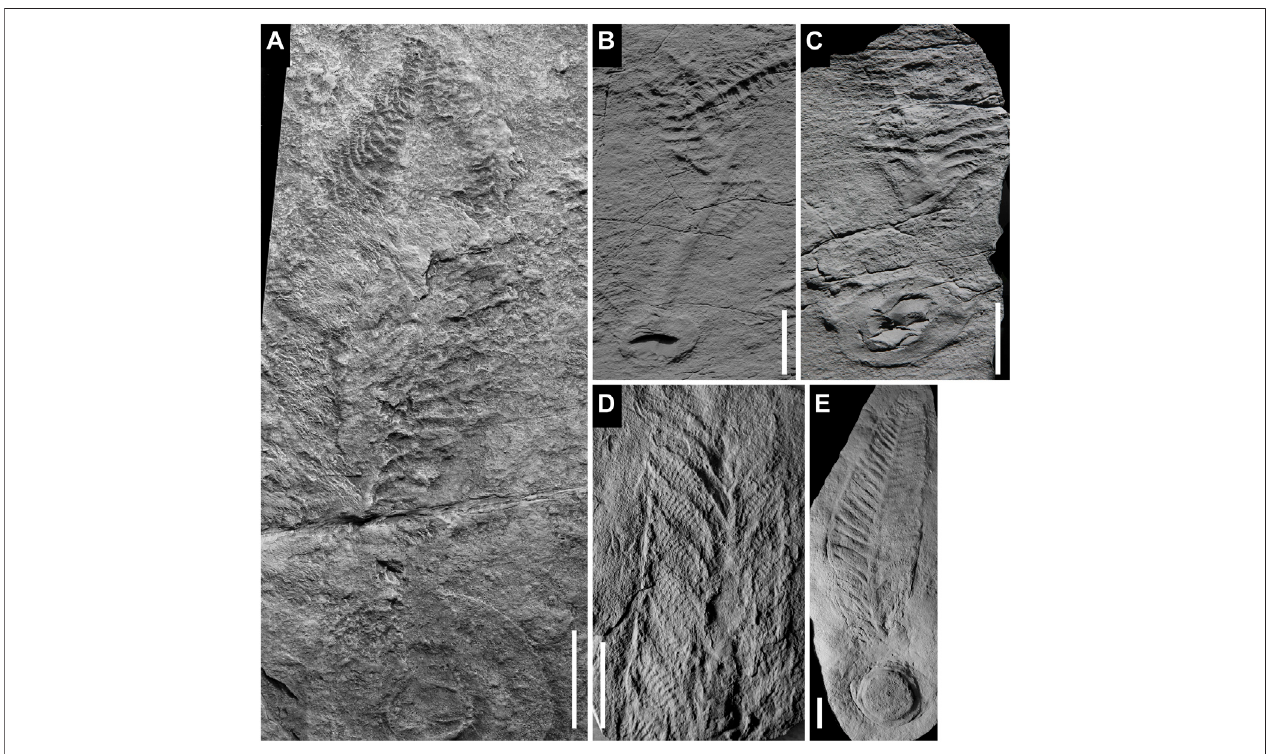
FIGURE 2 | Casts of relevant Charniodiscus species. (A) C. concentricus holotype (LEIUG 2383) from Charnwood Forest, UK. (B,C) C. procerus and C. spinosus respectivelyfromtheupperpartoftheMistakenPointFormation( ‘‘ E ’’ -surface)atMistakenPoint,Newfoundland.Jesmonitecastof fi eldspecimens. (D,E) C.longus cast (SAM P13777) and C . arboreus (Arborea) cast (OUMNH AW.00043/p) respectively from Ediacara, South Australia. Scale bars 3 cm. Not